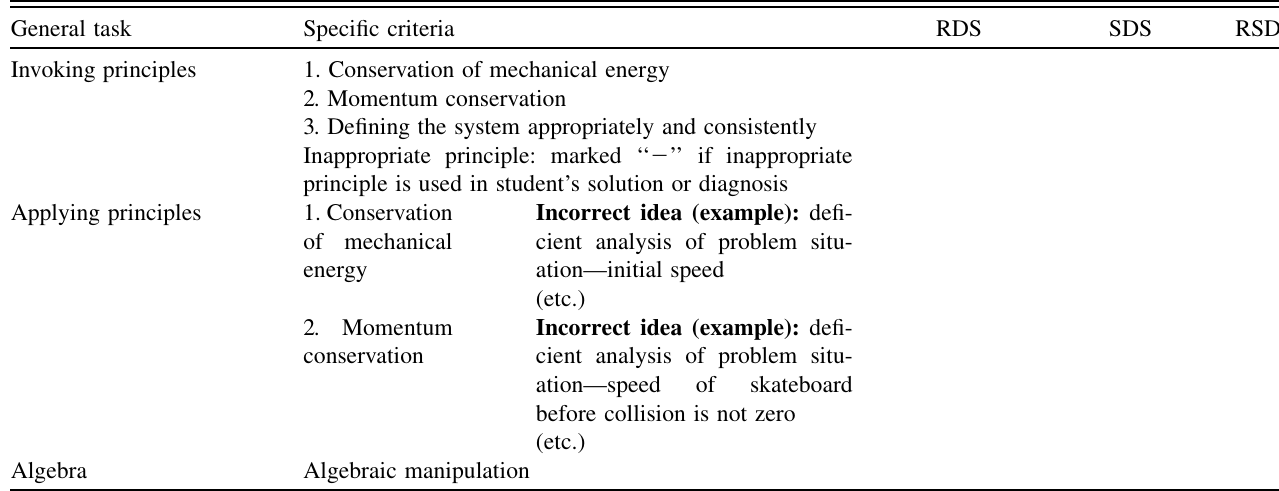
TABLE IV. Self-diagnosis grading rubric adapted to pre (quiz 7) problem. The last three columns would be filled in similarly for a sample student as they are for Table IV in the companion paper [9]; here, there is no student sample. The titles for the last three columns are as follows: RDS refers to the researcher diagnosis of student’s solution; SDS, student’s self-diagnosis of solution; RSD, researcher’s assessment of student’s